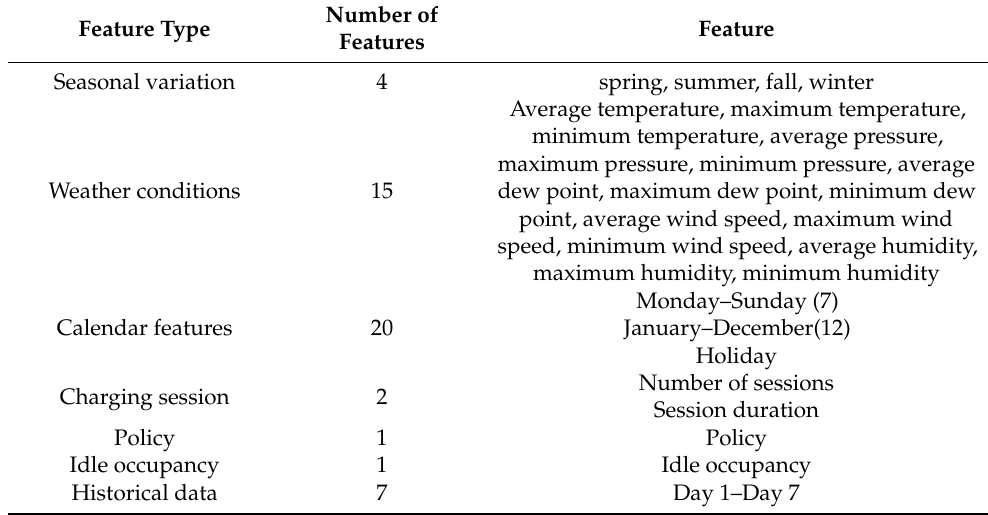
Table 5. Summary of the